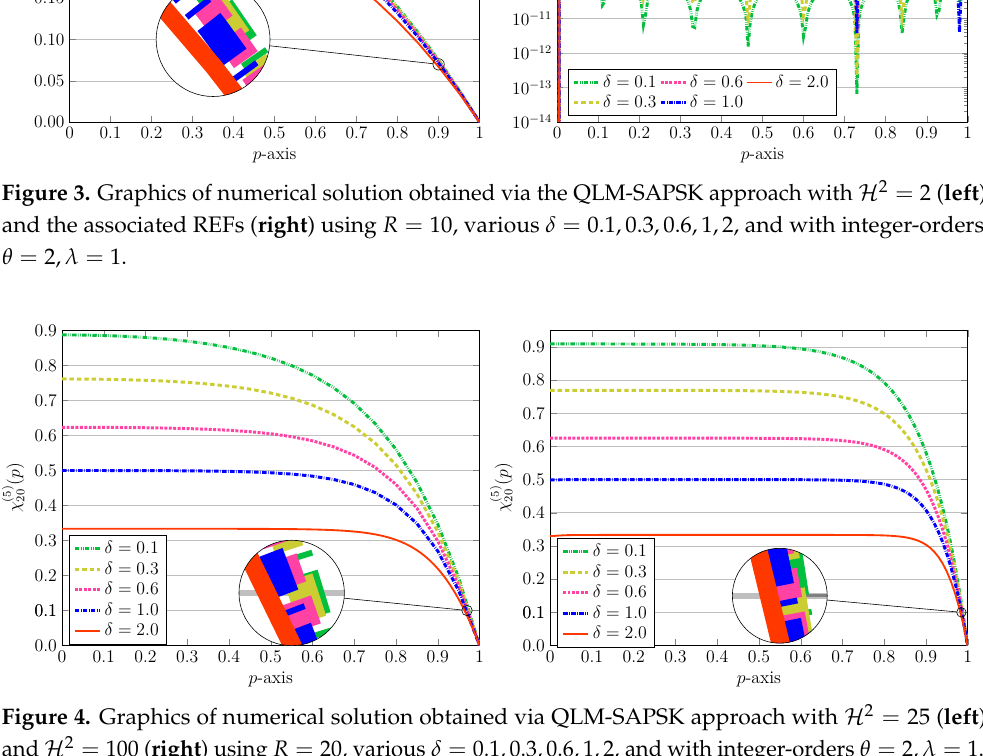
Figure 4. Graphics of numerical solution obtained via QLM-SAPSK approach with 2 = 100 ( right ) using R = 20, various δ = 0.1,0.3,0.6,1,2, and with integer-orders θ = 2, λ = and H